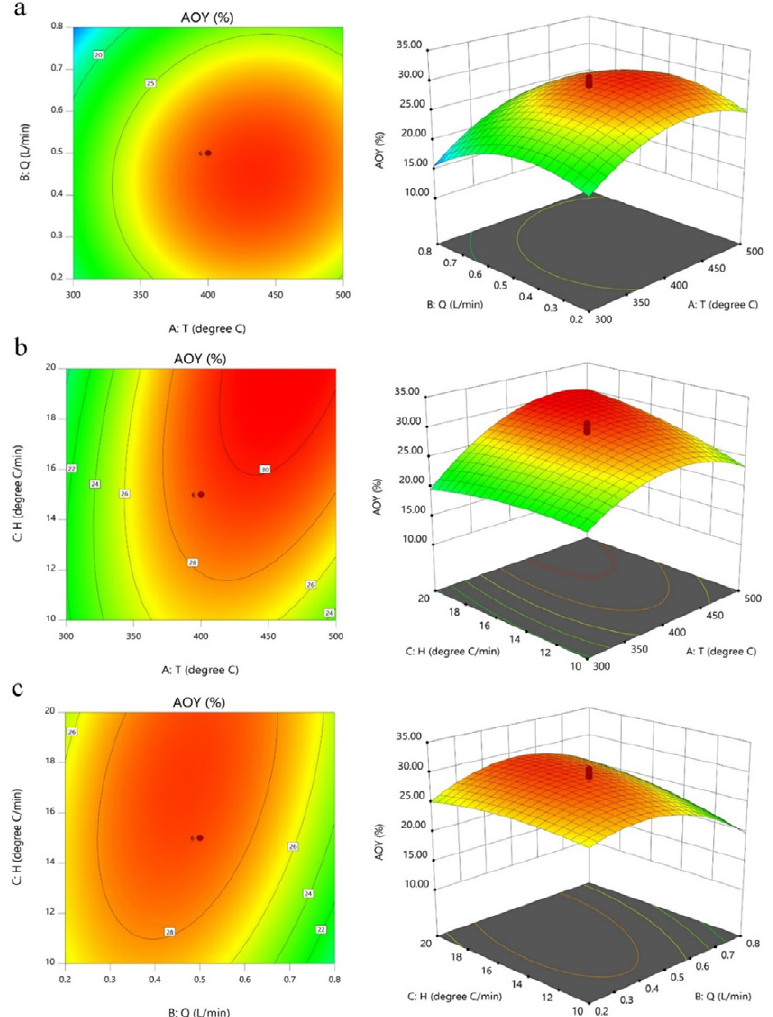
Fig. 2: The contour plots and three-dimensional response surface plots for the bio-oil yield of A. filiculoide : (a) temperature versus carrier gas flow rate; (b) temperature versus heating rate; (c) carrier gas flow rate versus heating rate